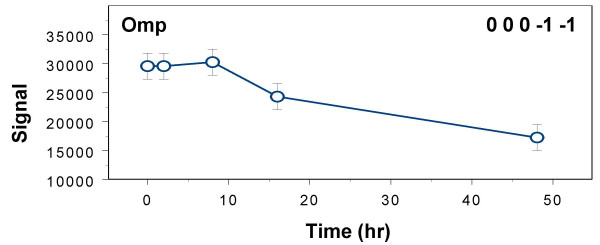
A simple diagram to illustrate the expressionpattern of the gene Omp. Mean hybridization signals (± SD) at each time point were plotted. The expression of Omp was unchanged at 2 hr and 8 hr following OBX. Its first significant change in expression was a down-regulation at 16 hr post-OBX. Its expression continued to decrease at 48 hr. The fluctuation pattern of Omp expression was indexed by (0 0 0 -1 -1), shown in the upper right corner of the graph. Diagrams in the following figures were plotted similarly.